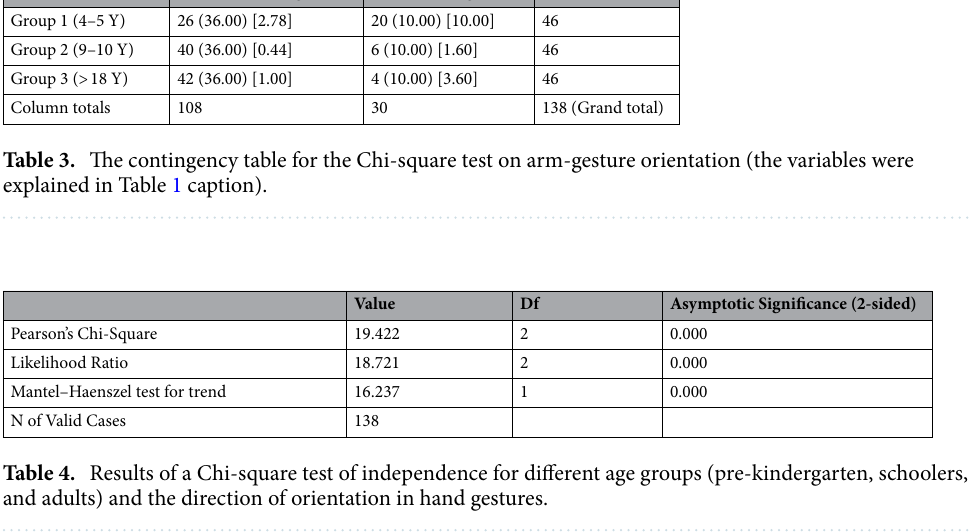
Horizontal arm gesture Vertical arm gesture Row totals